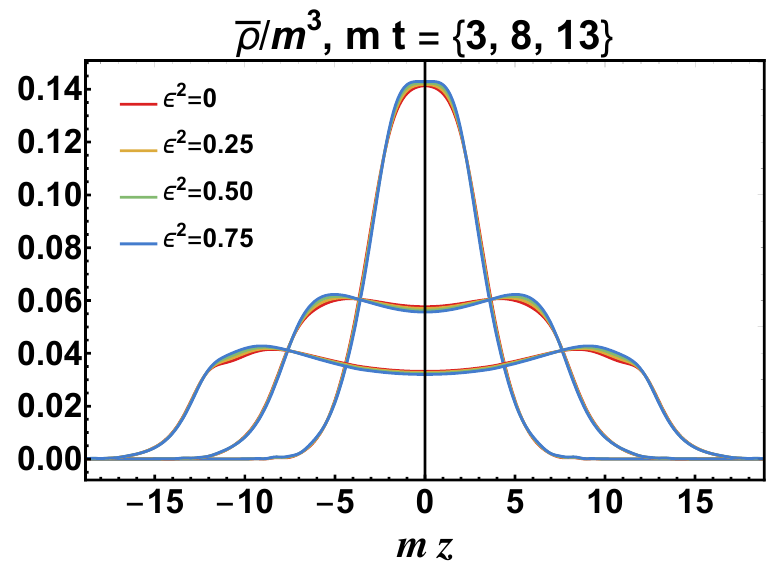
Figure 11 . The e(cid:11)ect of (cid:15) 2 on the (cid:22) (cid:26) distribution at three times after a collision of thick sheets, for (cid:21) = (cid:0) 0 : 2, (cid:12) = 0 : GB